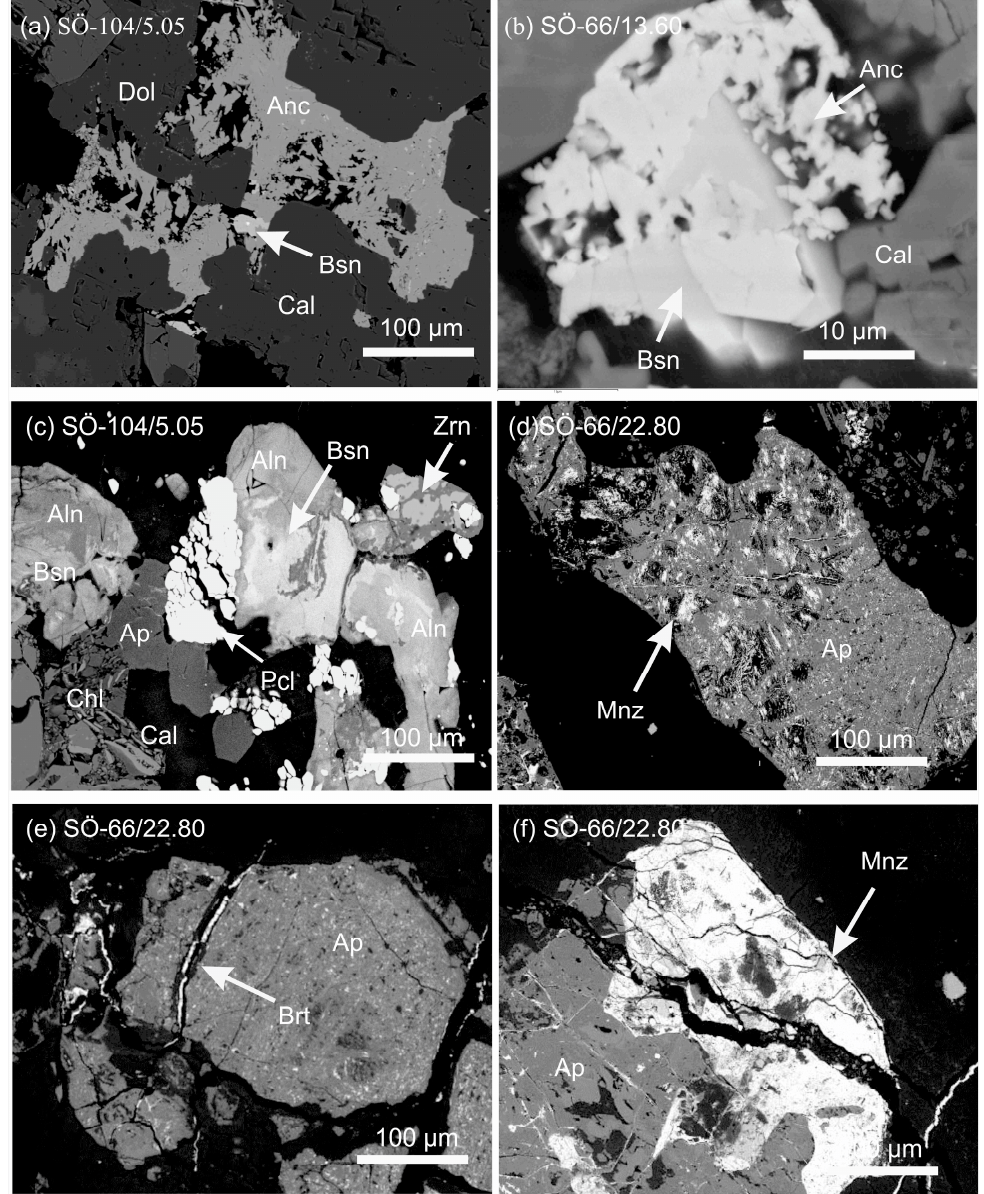
Figure 5. Back-scattered electron images of REE-bearing minerals from the Korsnäs carbonatite; ( a ) Ancylite (Anc) with carbonate minerals as calcite (Cal) and dolomite (Dol); ( b ) Overgrowth bastnäsite (Bsn) and ancylite (Anc); ( c ) Allanite (Aln) and bastnäsite (Bsn) associated with deformed pyrochlor (Pcl) crystals, euhedral apatite (Ap) and zircon (Zrn); ( d ) Large clusters of monazite grains occur as inclusions within apatite phenocryst; ( e ) Barite (Brt) filling fractures within apatite grain; ( f ) Monazite associated with apatite and barite.